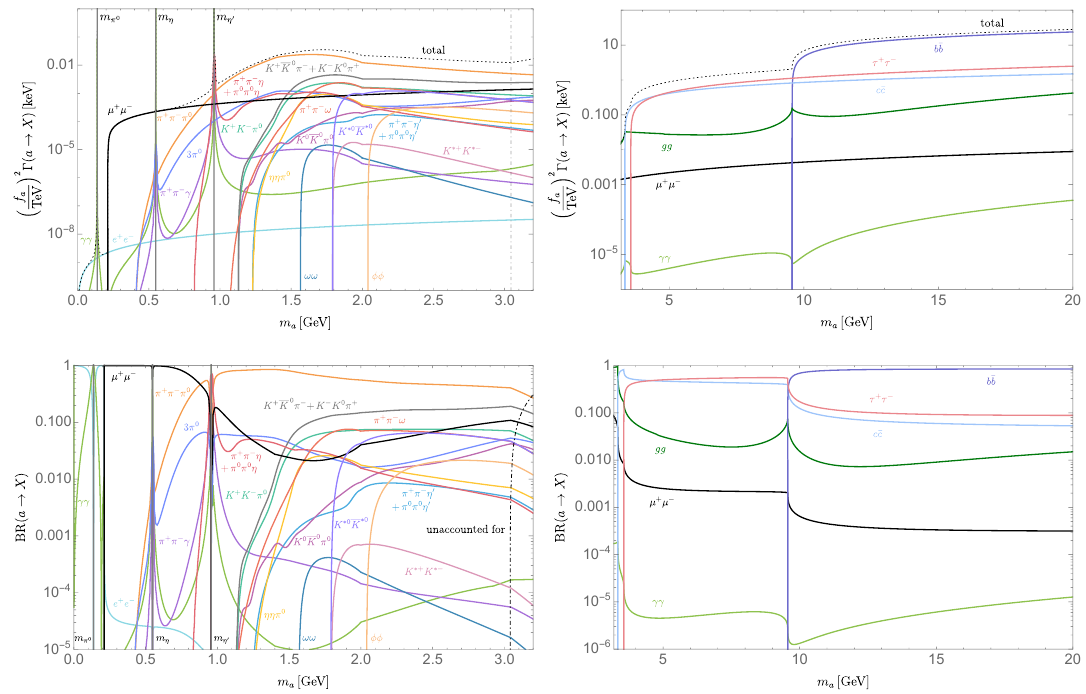
Figure 1 . Decay widths (top) and branching ratios (bottom) of a light ALP coupled to SM fermions with c = T 3 . In the top left panel the vertical dot-dashed line indicates the m = m trans f a a Lf where our evaluation of the total hadronic width transitions from P Γ( a → excl ) to Γ( a → gg ) . i i Correspondingly, in the bottom left panel the dot-dashed curve displays the branching ratio that is not captured by the considered exclusive modes. Note that at m trans the NLO QCD correction to a Γ( a → gg ) in eq. (A.3) is 235 α ( m trans ) / (12 π ) ≈ 1 . 6 times the leading order, suggesting a sizable s a residual uncertainty for this